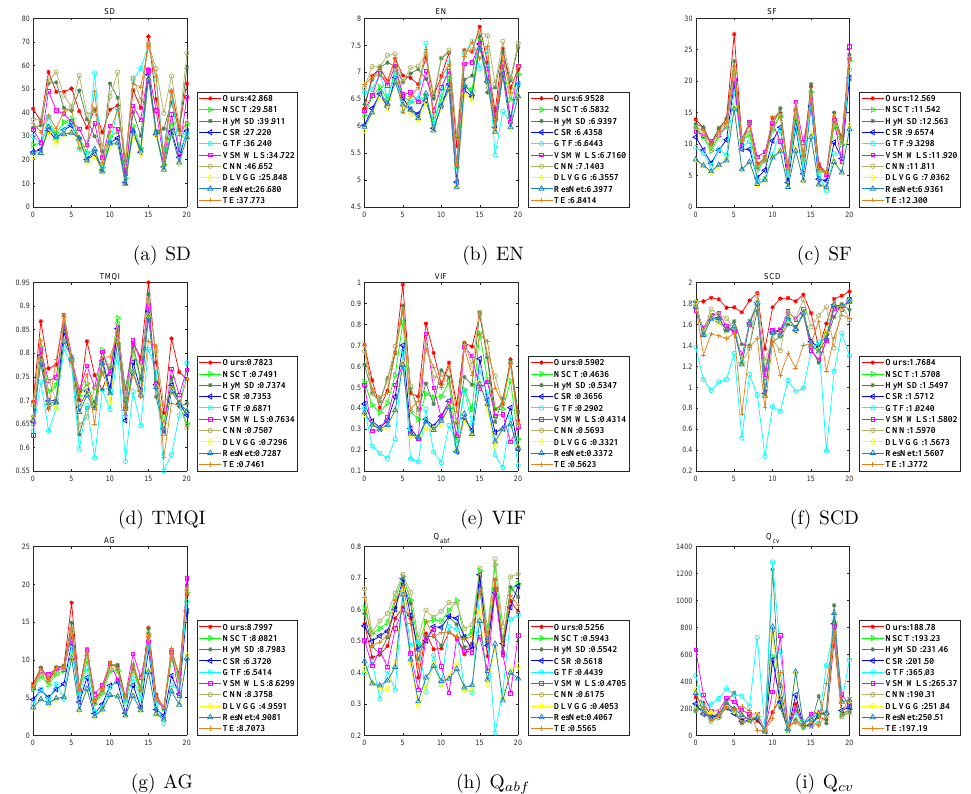
Figure 10. Quantitative comparisons of nine metrics using nine representative methods on 21 IR and visible image pairs. For all methods, the average values are given in the legend. From 0 to 20: ‘Road’, ‘Camp’, ‘Kaptein’, ‘Kaptein1654’, ‘Factory’, ‘S1’, ‘Octec’, ‘Sandpath’, ‘Soldiers with jeep’, ‘Trees4906’, ‘Kaptein19’, ‘Pancake house’, ‘Helicopter’, ‘Soldier behind smoke’, ‘Marne04’, ‘S2’, ‘Pedestrian’, ‘Kayak’, ‘T1’, ‘T2’, and ‘Bench’. ( a ) SD, ( b ) EN, ( c ) SF, ( d ) TMQI, ( e ) VIF, ( f ) SCD, ( g ) AG, ( h ) Q abf , ( i ) Q cv